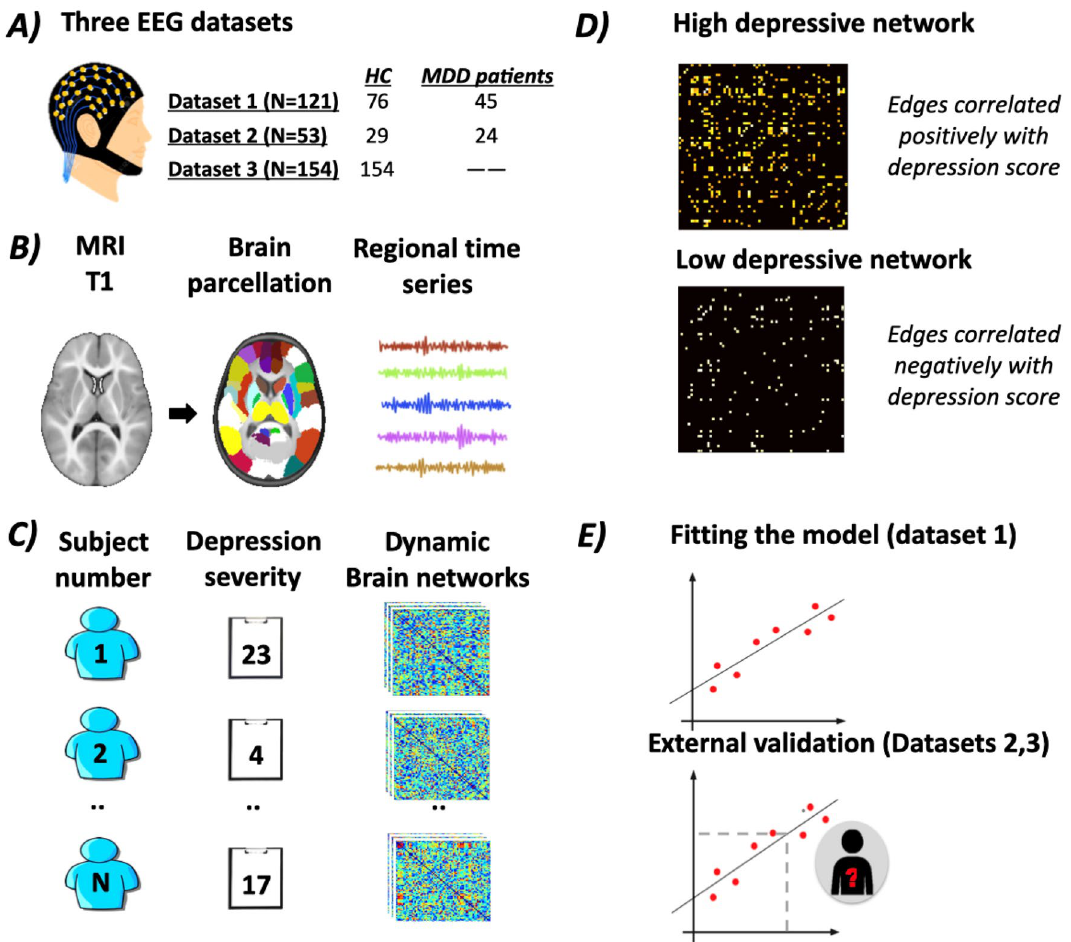
Figure 1. The full pipeline of our study. ( A ) EEG signals were acquired from three datasets: (1) N = 121 subjects (76 healthy controls and 45 MDD patients), (2) N = 53 subjects (29 healthy controls and 24 MDD patients) (3) N = 154 healthy subjects. ( B ) A template Magnetic Resonance Imaging (MRI) was segmented into 68 regions of interest (ROIs) by the means of Desikan Killiany atlas. Then, the regional time series of each subject were reconstructed using the weighted minimum norm estimate inverse solution (WMNE). ( C ) The inputs of the connectome-based predictive modeling (CPM) are the connectivity matrices and the depression score of each subject (BDI -i.e. dataset1-, Hamilton -i.e. dataset2, dataset 3-). The brain networks of each subject were obtained by computing the phase locking value between the regional time series. (b) The training step: across all subjects, each edge is correlated to the BDI score. Then, the algorithm selects the most important edges using significance testing (p < 0.01). Two matrices are thus resulted: the first corresponds to the network positively correlated with BDI and the second represents the network negatively correlated with BDI. ( E ) SVR predictive model is built to find the relationship between BDI and the sum of edge weights of the matrices obtained in the previous step. This model is then applied to predict the depression severity of subjects from the second and third EEG acquisition and pre‑processing. During experiment, participants were required to relax, stay awake and try avoiding movements while 5 min eye-closed resting state EEG were recorded in a sound-proof room. 128-chan- nel HydroCel Geodesic Sensor Net (Electrical Geodesics Inc., Oregon Eugene, USA) was used and electrode signals were referenced to Cz. During acquisition, each electrode kept an impedance below 50 kΩ. EEG pre- processing was performed in the same way dealt with the first dataset, leading to four artifact-free epochs of 40-s lengths for each participant. Third dataset.